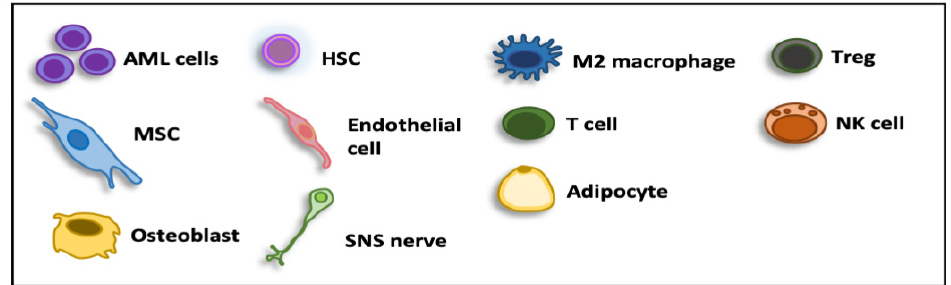
Figure 2. Interaction between AML cells and the bone marrow microenvironment. Within the niche, AML cells communicate with mesenchymal stem cells and endothelial cells in order to in- crease bone marrow vascularization and alter vascular permeability ( yellow panel ); Moreover, AML cells strongly reprogram MSCs, leading to a self-reinforcing niche at the expense of normal hematopoiesis ( pink panel ); Leukemic cells escape the immune system and recruit anti-inflammatory components such as Treg and M2 macrophages ( light blue panel ); AML cells exploit stromal cells to enhance their antioxidant defenses and adipocytes as a source of cellular energy ( green panel ).